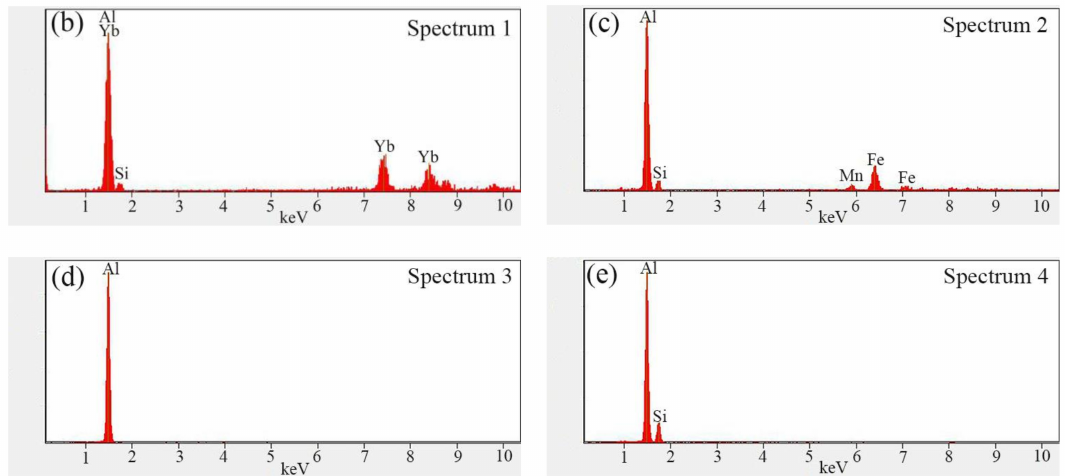
Figure 11. The tensile fracture analysis and EDS analysis of the alloy with 0.8 wt % Yb